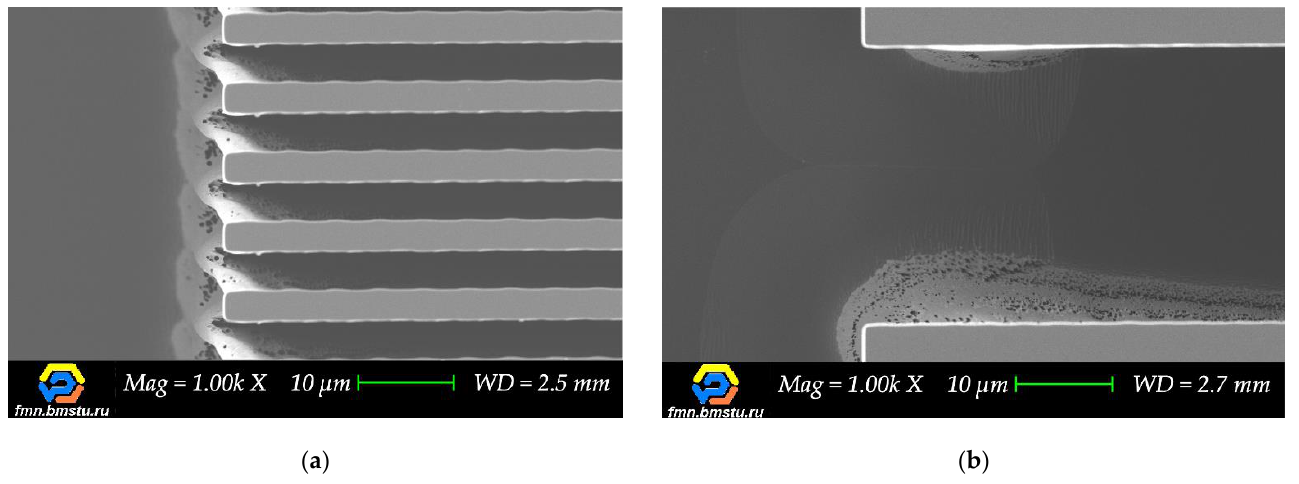
Figure 15. Polymerization at the intersections of transverse crossing auxiliary lines (S = 100 μm) with: ( a ) 5 μ m wide target line; ( b ) 50 μ m wide target line.